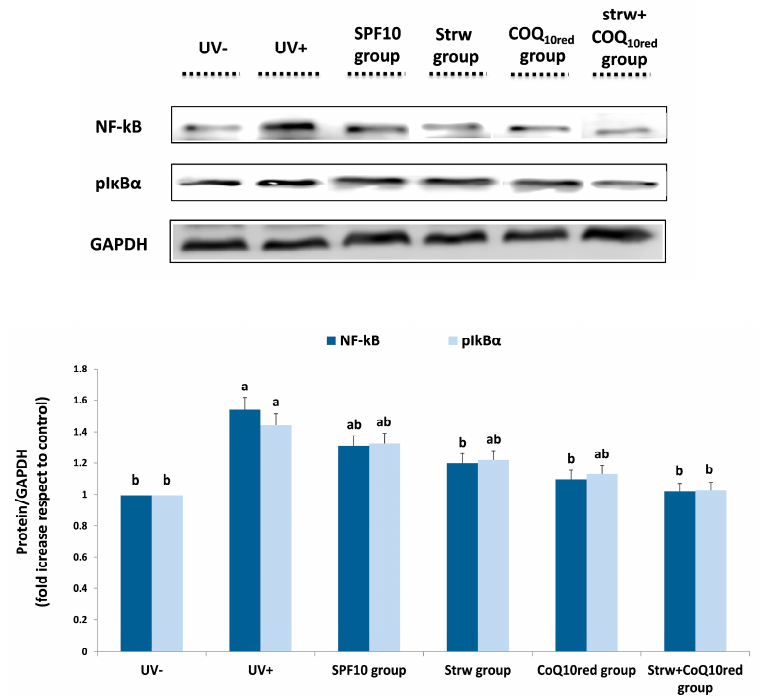
Figure 6. Levels of inflammatory markers (NF-kB, pIkB α ) in human dermal fibroblast (HDF) cells irradiated with ultraviolet A (UVA, 275 kJ/m 2 ) radiation (UV+) or not irradiated (UV − ), after 1 h of exposure. HDF were screened with different formulations as explained in the text. Data are expressed as mean values ± standard deviation (SD). Columns belonging to the same set of data with different superscript letters are significantly different ( p <